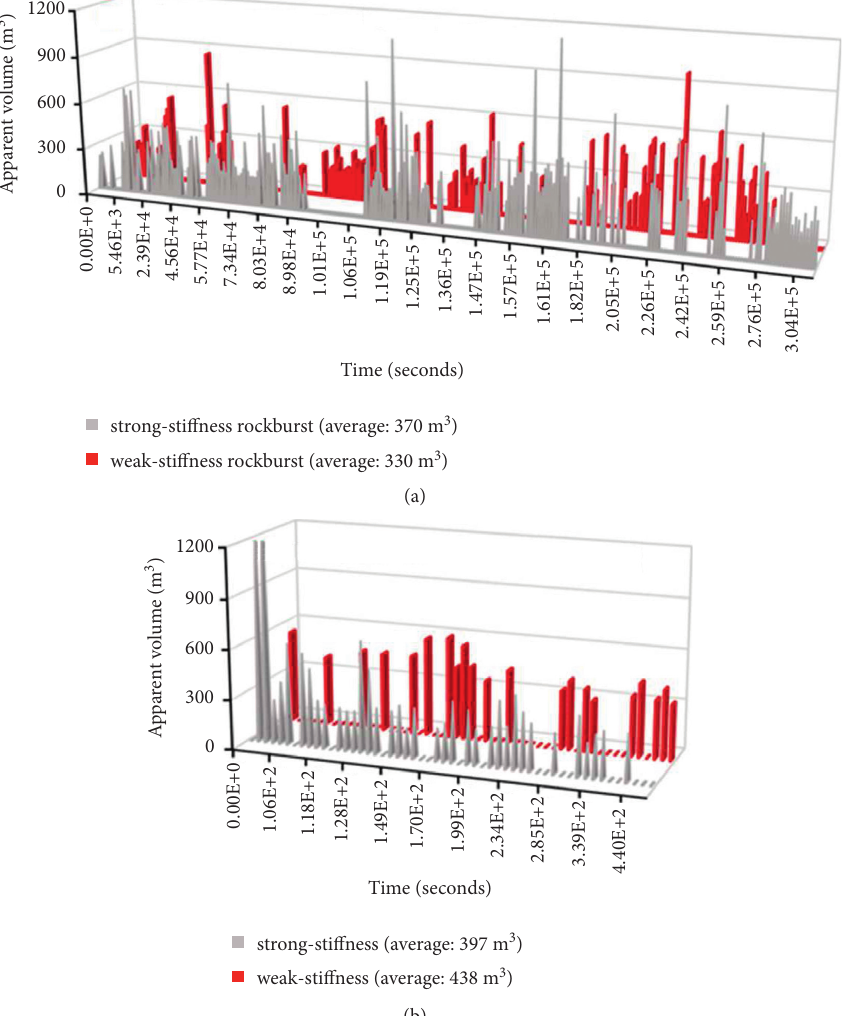
Figure 7: The apparent volume series of microseismic events during rockburst: (a) the development stage; and (b) the occurrence